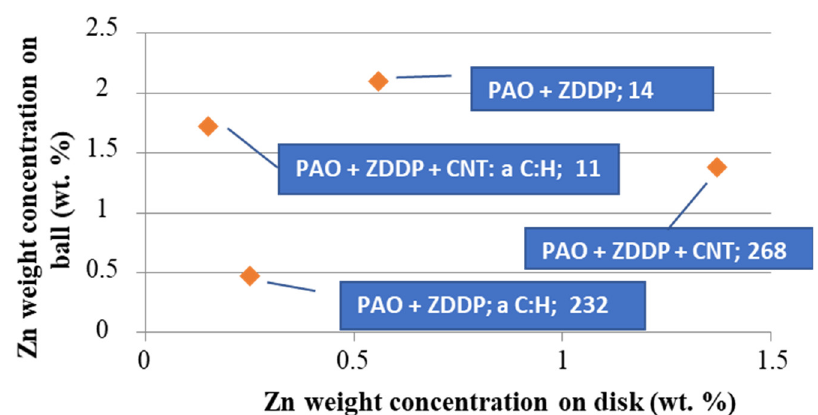
Figure 15. Relationship between the concentration of Zn on the ball and that on the disc after the tribological tests; the numbers provided correspond to the wear scar areas ( µ m 2 ).